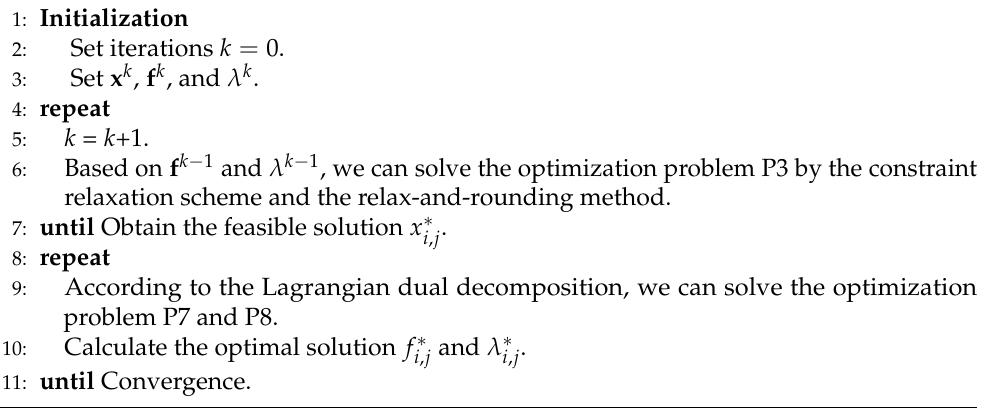
Algorithm 1 The Proposed LBTO